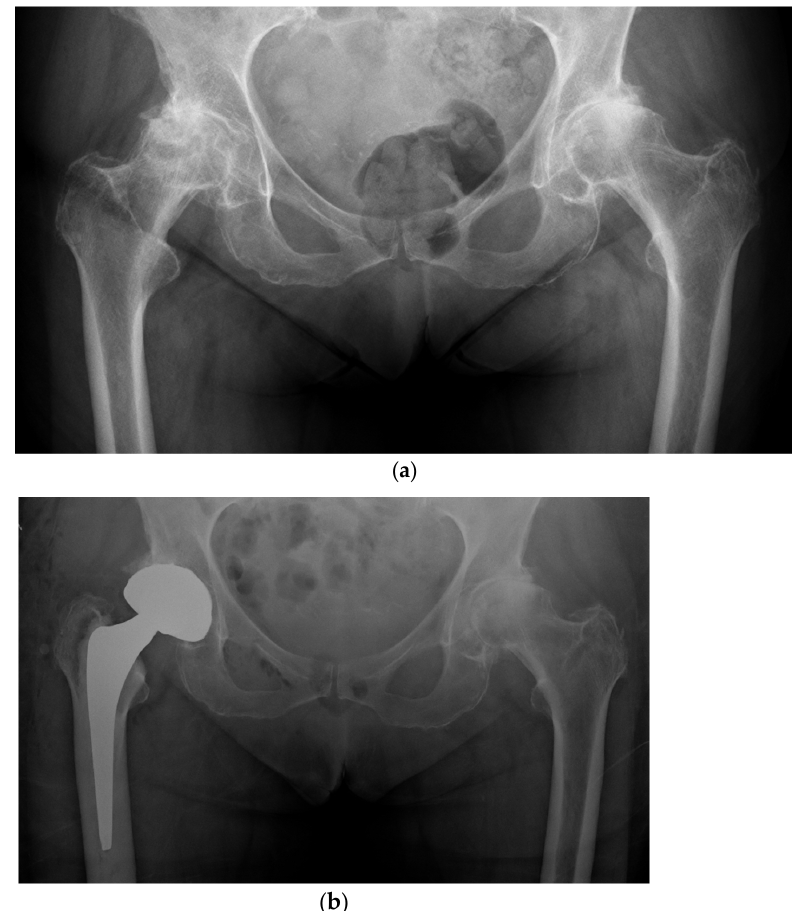
Figure 7. ( a ) Antero-posterior pelvis radiograph of a 75-year-old woman with severe bilateral hip osteoarthritis. During the right THA surgery, the acetabular cavity was reamed to 47 mm. A monobloc acetabular component of 48 mm was implanted with a DM polyethylene head of 41 mm (28 mm metal head). A polished tapered stem was cemented. ( b ) Post-operative anteroposterior pelvis radiograph.